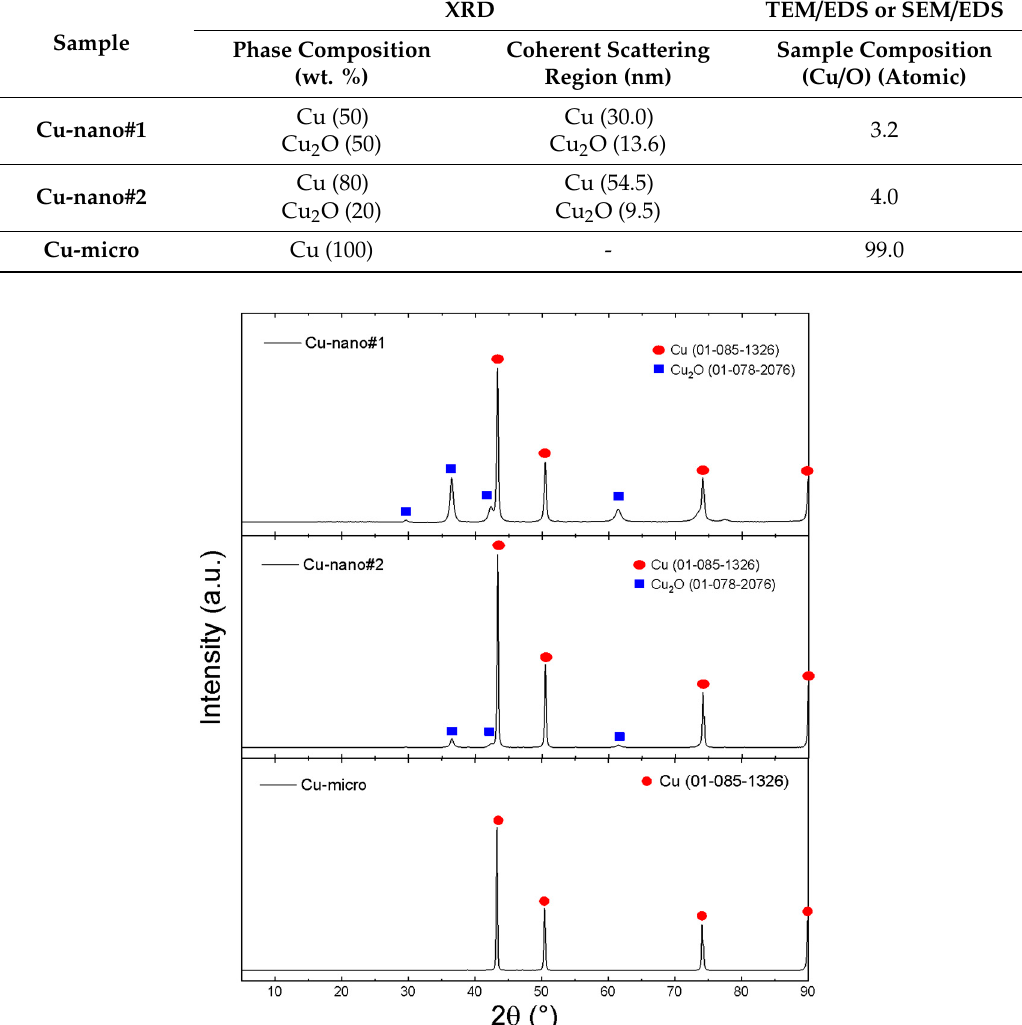
Figure 1. XRD of Cu-nano#1, Cu-nano#2 and Cu-micro.